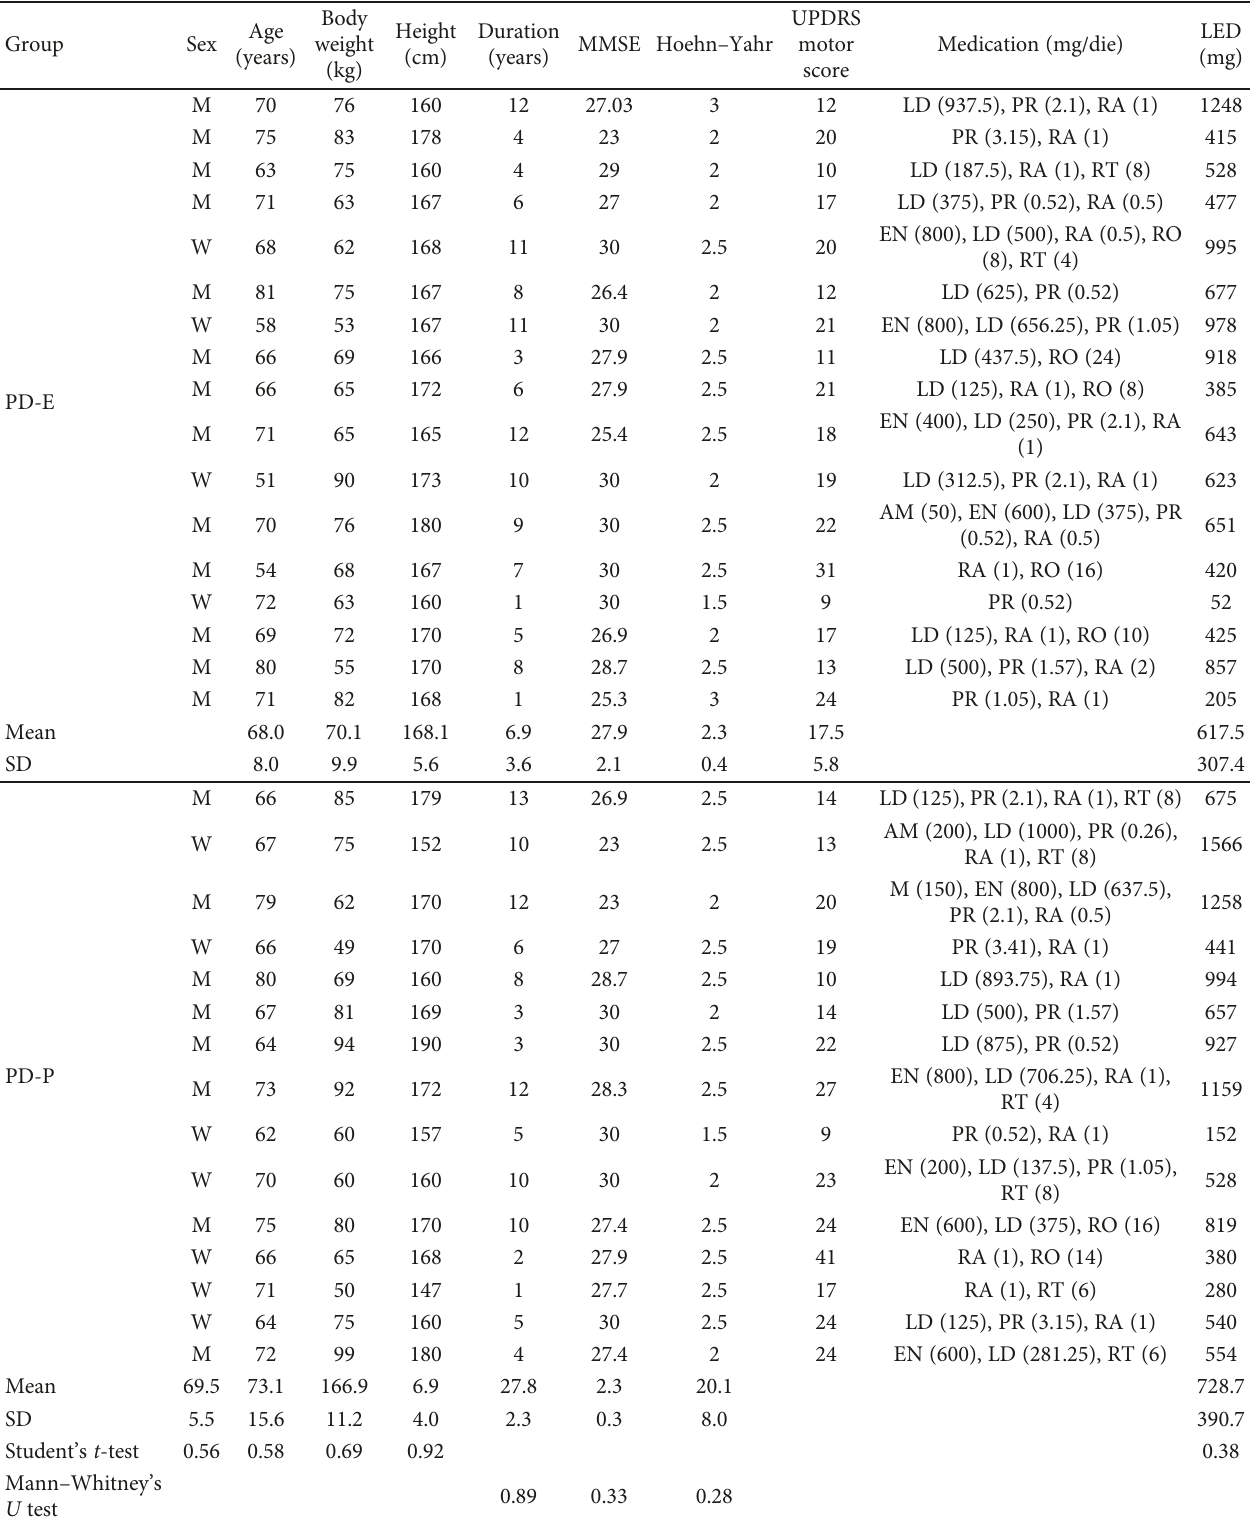
Table 1: Demographics, clinical details, and medication of the 32 patients with PD who participated in the study, divided into the two training groups: PD-E (exercises) and PD-P (platform). The two groups were homogeneous at baseline, as shown by Student ’ s t -test and Mann – Whitney U